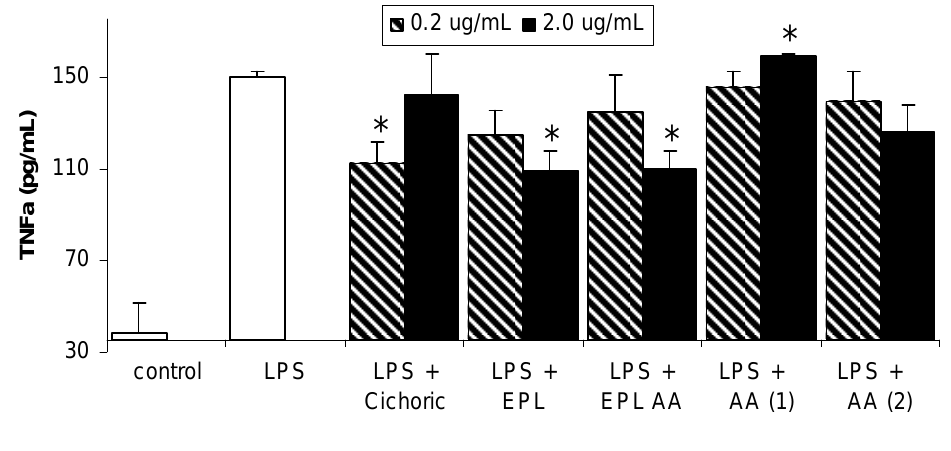
Figure 4: Effects of Echinacea and its components on LPS-induced nitric oxide production in macrophages. Data are expressed as mean ± SEM for n = 6. * significantly different from LPS only stimulated cells, where p<